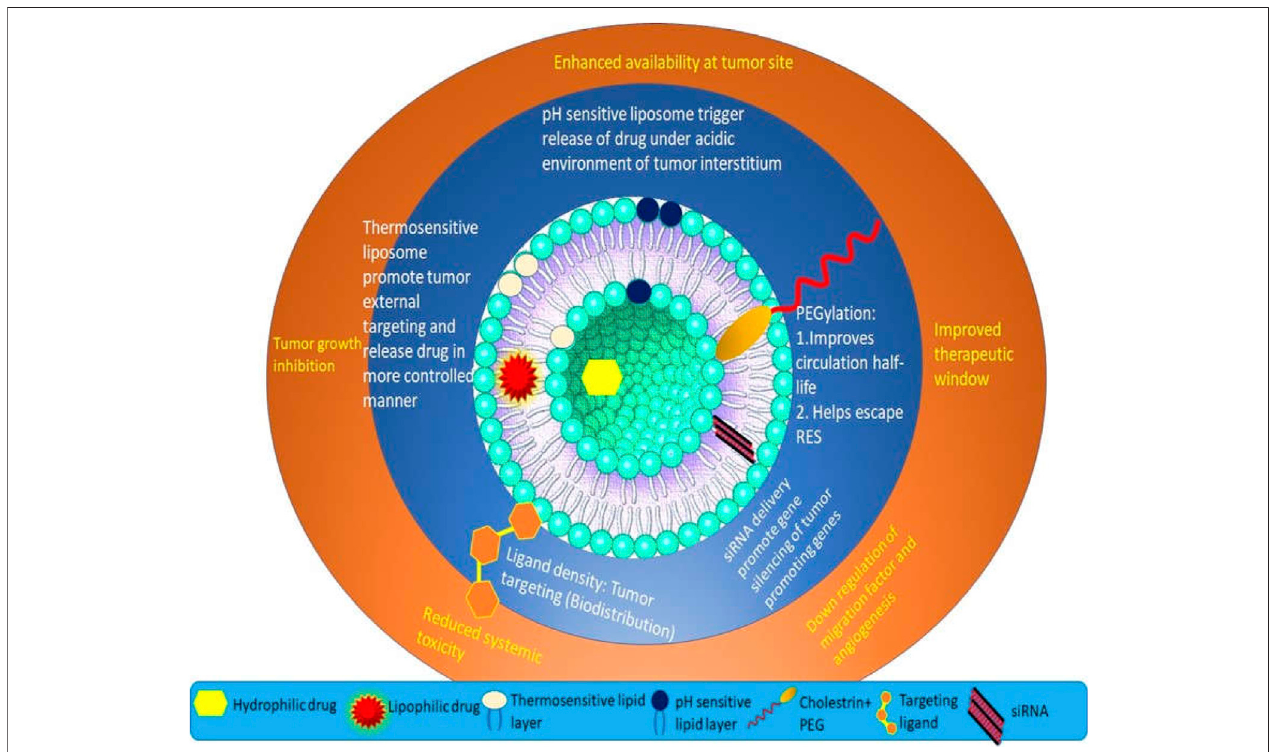
FIGURE 1 | The scope of liposomes in mediating anti-cancer